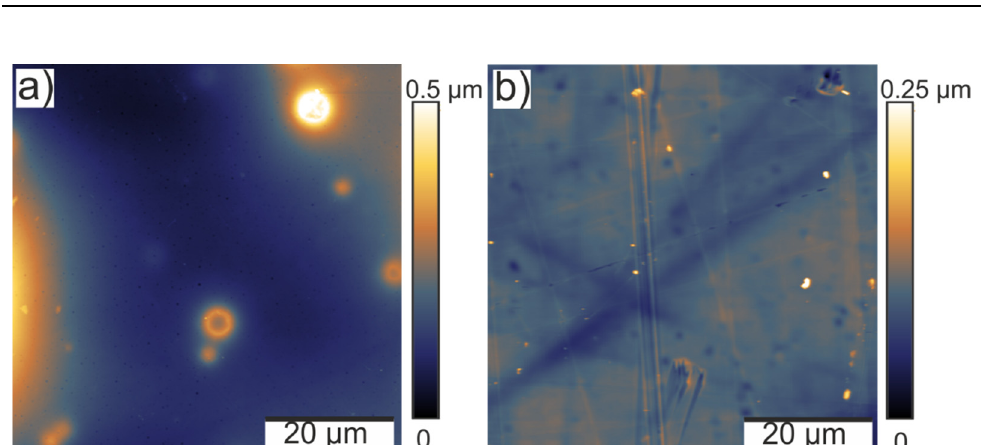
Figure 9. AFM images of ( a ) a drop-coated and ( b ) a brush-coated layer of coat_1_180 on a Si wafer and a steel plate, respectively.